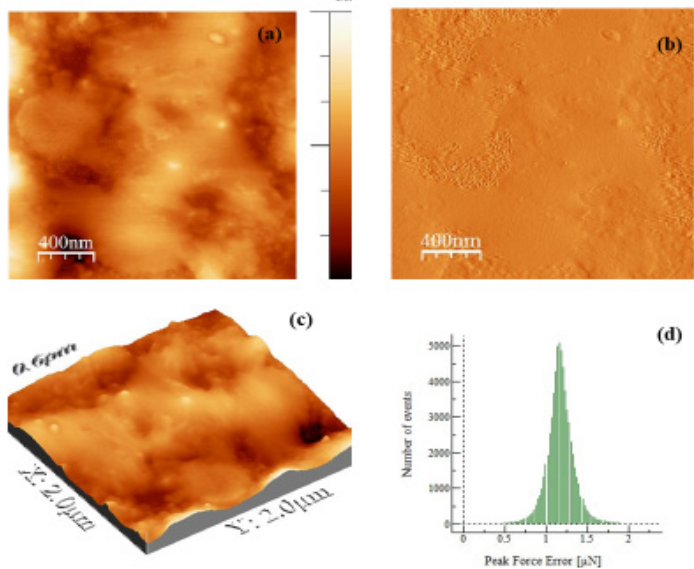
Fig .10. (a) Topographic image, (b) Phase image, (c) Three-dimensional structure,(d) Roughness surface